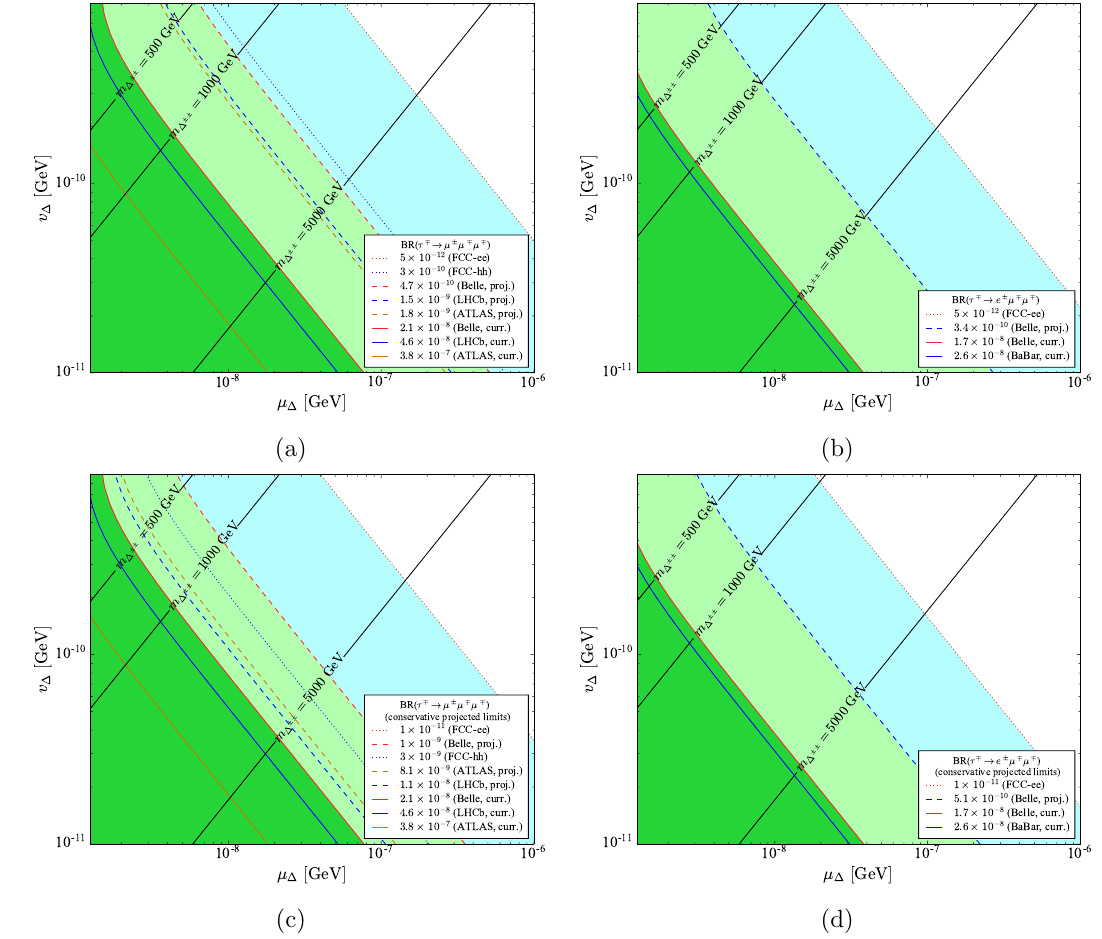
Figure 2. Current and future branching ratio limits in the parameter plane of (cid:22) the Type-II Seesaw Model. (a) Shows the limits from the decay (cid:28) (cid:7) ! (cid:22) (cid:6) (cid:22) (cid:7) (cid:22) (cid:7) , and (b) shows the limits from the decay (cid:28) (cid:7) ! e (cid:6) (cid:22) (cid:7) (cid:22) (cid:7) . The same two decay processes are shown in (c) and (d) but with the conservative estimates for the projected limits instead. The solid black lines represent constant values of the mass of the doubly charged Higgs (cid:1) (cid:6)(cid:6) .